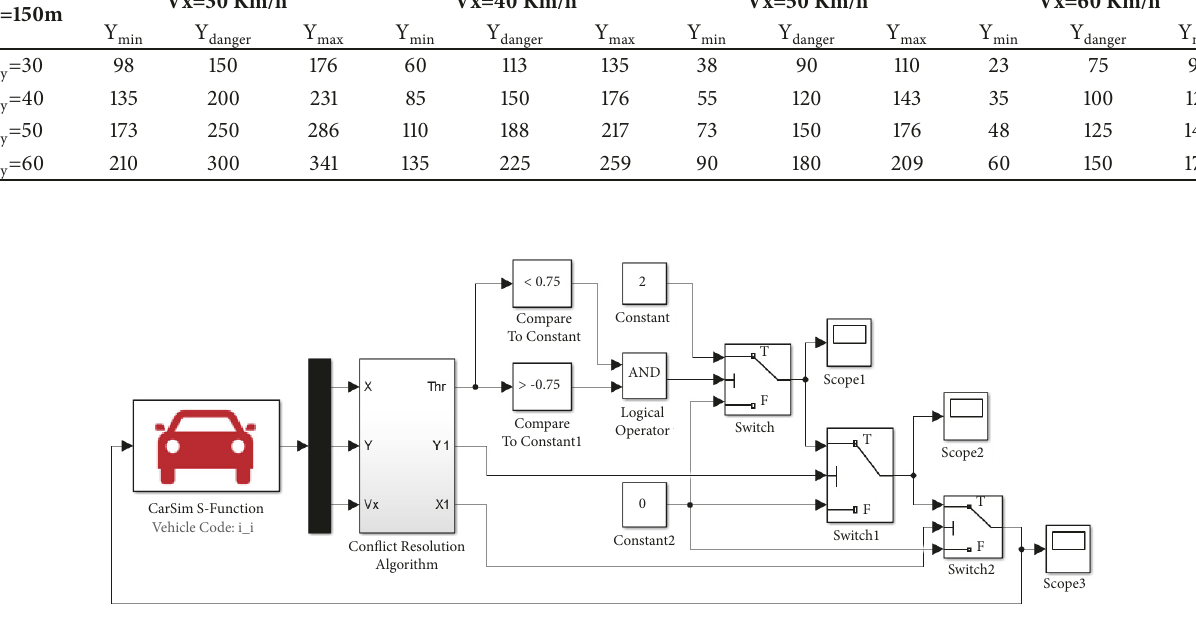
Figure 7: Simulink logic